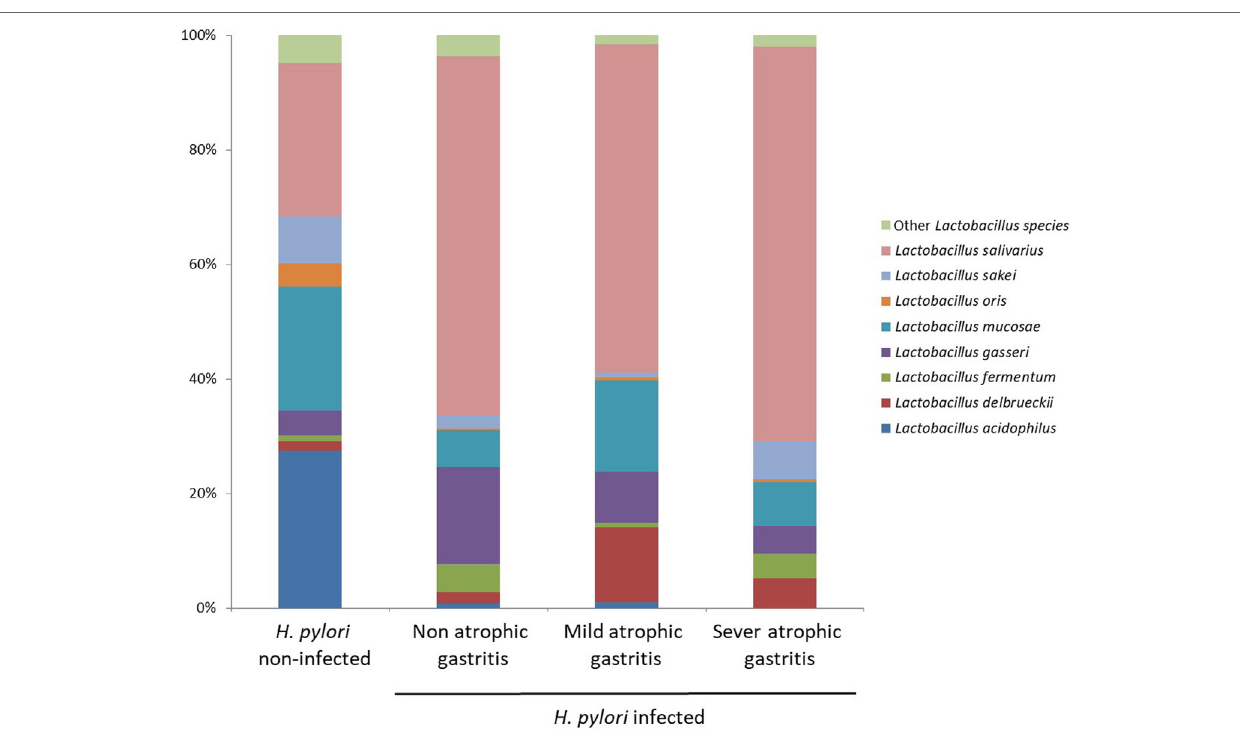
FigUre 5 | Proportion of Lactobacillus species in Helicobacter pylori -infected subjects divided by degree of atrophic gastritis and non-infected